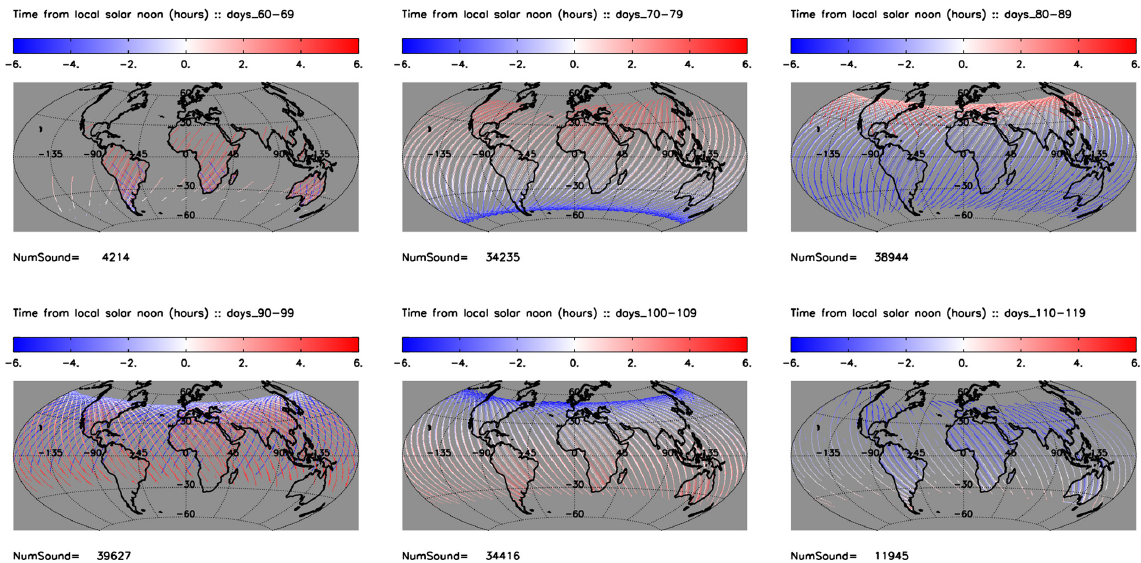
Figure 5. Simulated OCO-3 sampling pattern for six 10d periods, colored by the time in hours relative to local noon. The pixel size of individual footprints has been magnified for viewing